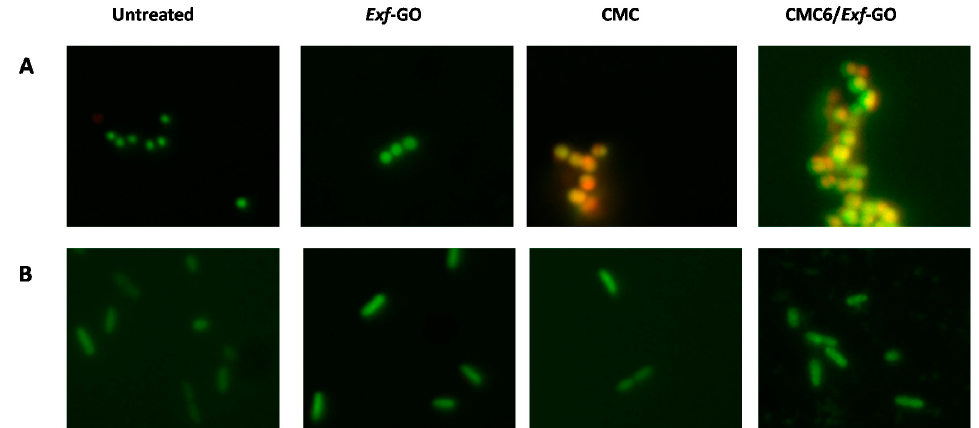
Figure 8. Fluorescence microscopy images of S. aureus ATCC ® 25923 ™ ( A ) and P. aeruginosa ATCC ® 10145 ™ ( B ), either not exposed (untreated) or exposed to Exf -GO, CMC and CMC6 /Exf -GO.